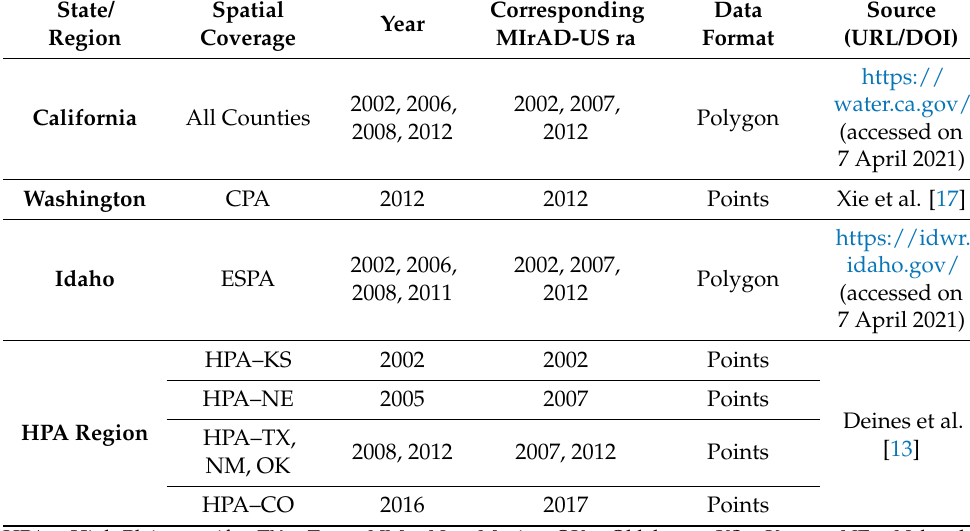
Table 1. Reference data used for accuracy